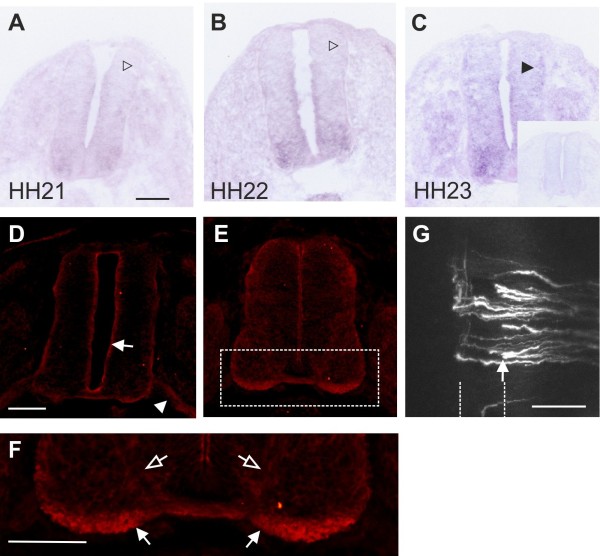
The temporal expression of RabGDI is consistent with its role as a regulator of Robo1 expression on commissural axons.RabGDI is not expressed by dorsolateral commissural neurons when their axons grow toward the floor plate between HH19 (not shown) and HH21 (open arrowhead in A) or when they have reached the floor plate at HH22 (open arrowhead in B). RabGDI is detectable only after commissural axons have entered the floor-plate area at HH23 (arrowhead, C). The adjacent section to the one shown in (C) was hybridized with the corresponding sense probe as a control (insert in C). At HH22, only very low levels of RabGDI protein were detectable in cells lining the central canal (arrow in D) and in motor axons (arrowhead in D). At HH24, RabGDI protein was localized almost exclusively to post-crossing axons (E,F; compare levels in post-crossing axons (arrow in F) with pre-crossing commissural axons (open arrow in F)). Following premature expression of RabGDI, many commissural axons failed to enter the floor plate (arrow in G), consistent with premature expression of Robo1 on commissural growth cones. Bar 100 μm in A-E and G
.